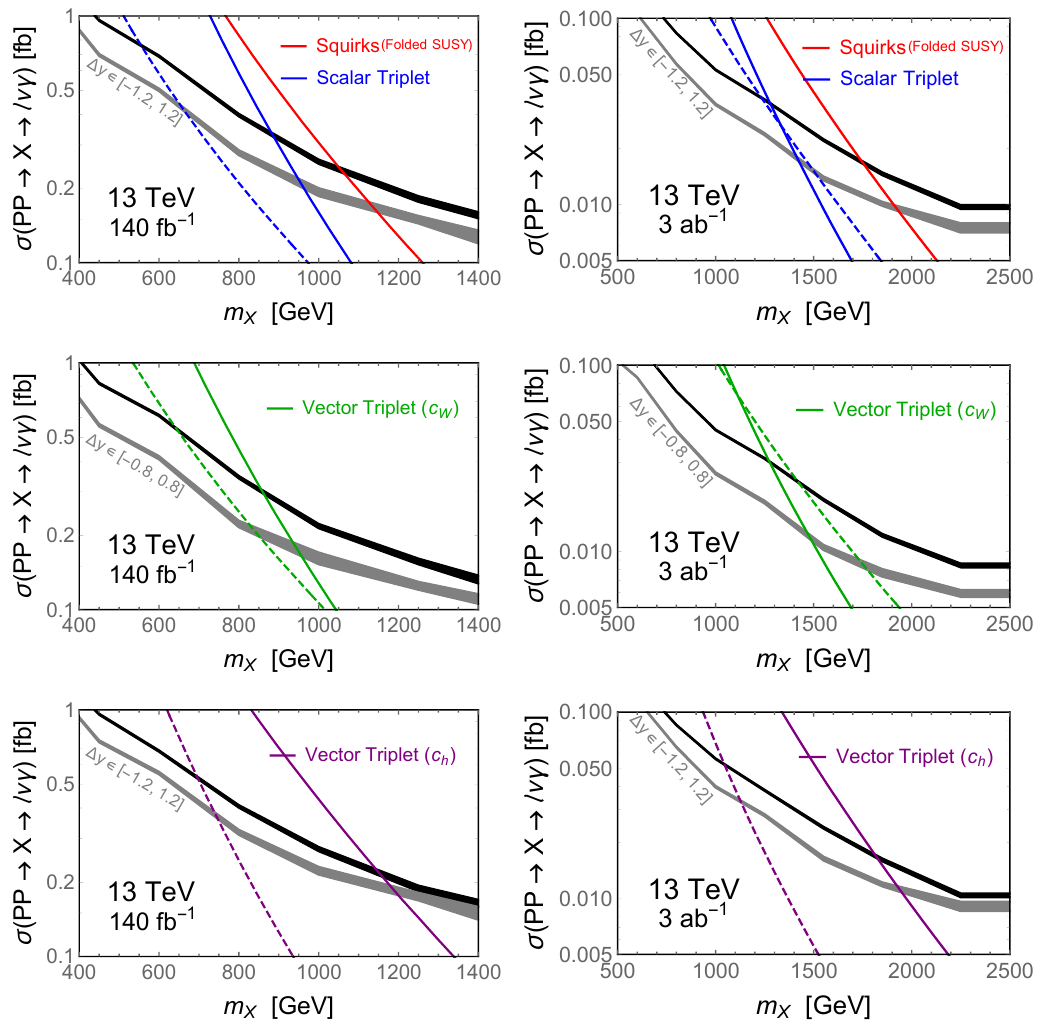
p Figure 6 . Sensitivity of W(cid:13) resonances of mass m X at the s = 13 TeV LHC assuming the current luminosity (140 fb (cid:0) 1 ) (left) and high luminosity (right). Top: Squirks in Folded Supersym- metry including two generations of squarks (red), and the Scalar Triplet model fo eq. (3.1) using the benchmarks (cid:3) = 5 m X , y m = 0 : 1 (solid) and (cid:3) = 10 TeV, y m = 0 : 15 (dashed). Middle: Vector Triplet c W model with benchmarks (cid:3) = 5 m X , g m = 0 : 03 (solid) and (cid:3) = 10 m X , g m = 0 : 06 (dashed). Bottom: Vector Triplet c h model with benchmarks (cid:3) = 5 m X , g m = 0 : 005 (solid) and (cid:3) = 10 m X , g m = 0 : 02 (dashed). The black bands were calculated assuming the signal model shown in each panel and using the entire m ‘(cid:23)(cid:13) distribution whereas the gray bands use m ‘(cid:23)(cid:13) along T T with RV cuts on (cid:1) y as shown in the gray label. The width of the bands come from considering a systematic error between once and twice as large as the statistical error in each m ‘(cid:23)(cid:13) T